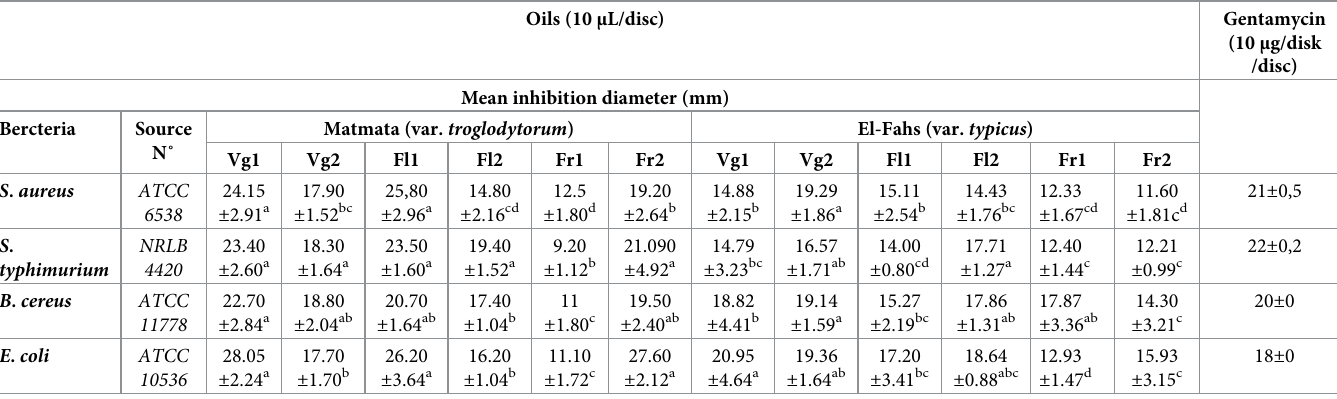
Table 3. Antibacterial activity of Rosmarinus officinalis essential oil samples.